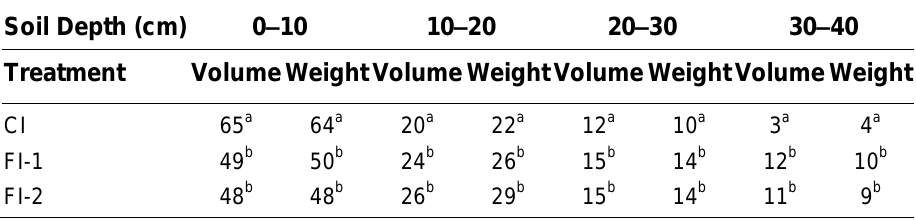
Root Volume (cm 3 ) and Dry Weight (g) at Different Soil Depth in 2002 Late Rice Experiment Conducted at Guandong Ocean University Experiment